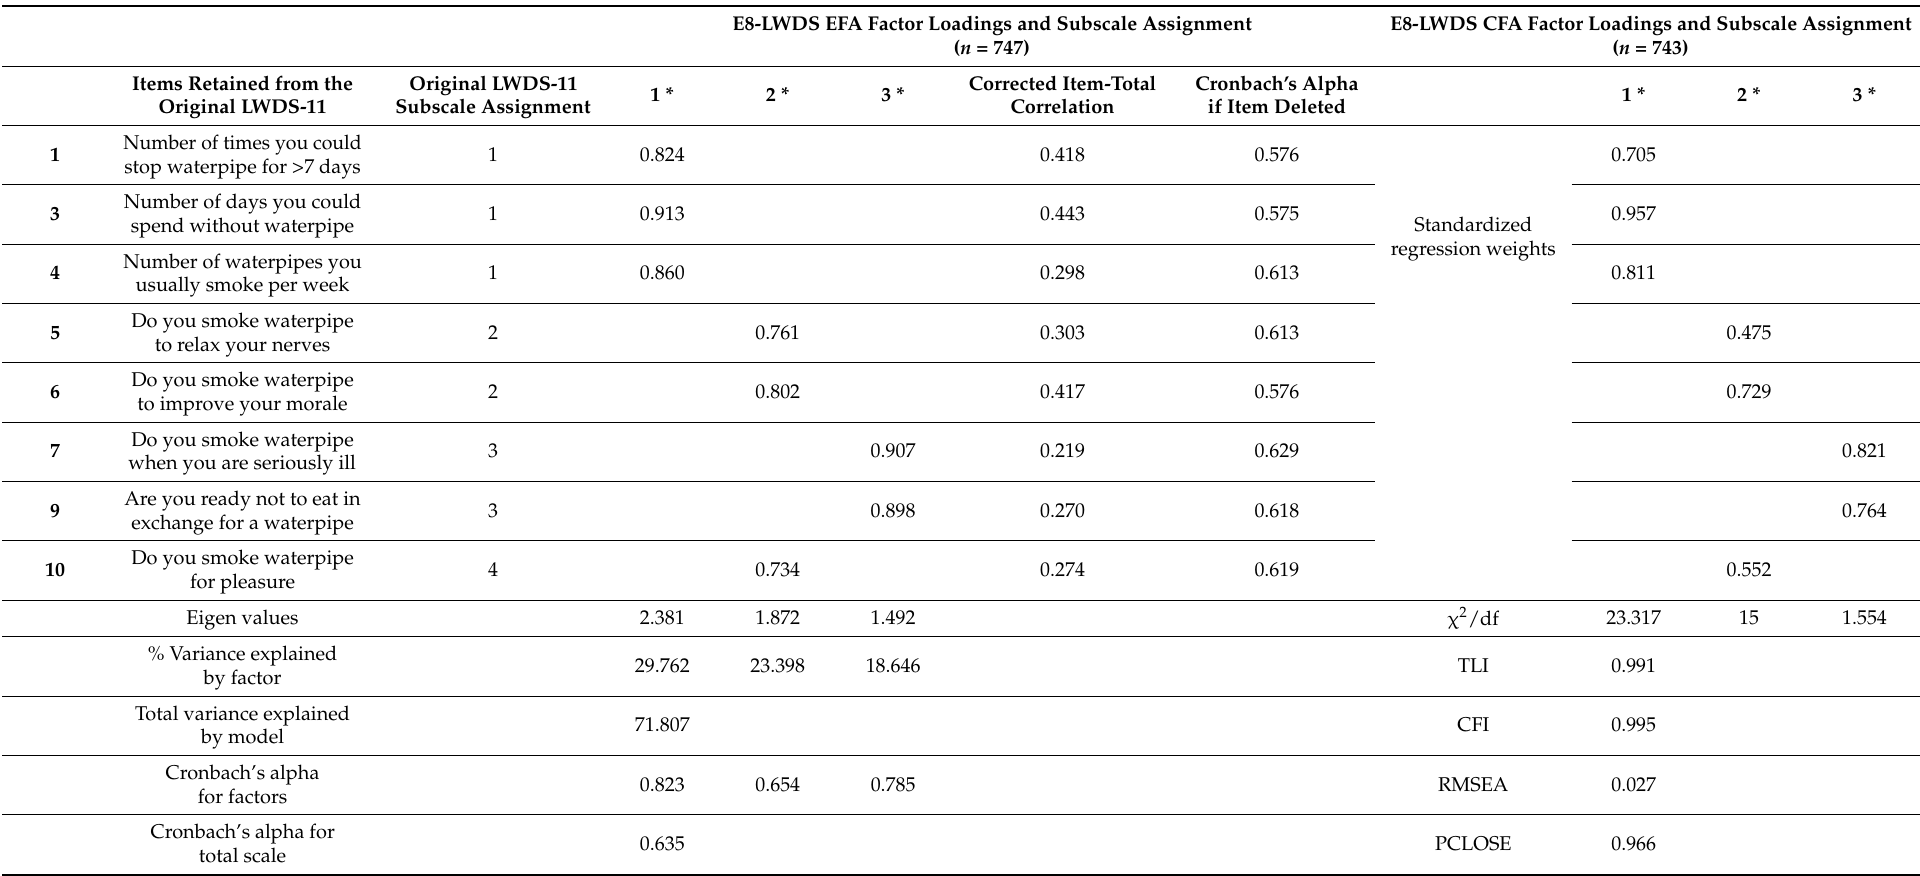
Table 2. Exploratory and confirmatory factor analysis, factor loadings, and structure of the E8-LWDS among current waterpipe tobacco smokers. E8-LWDS EFA Factor Loadings and Subscale Assignment ( n =